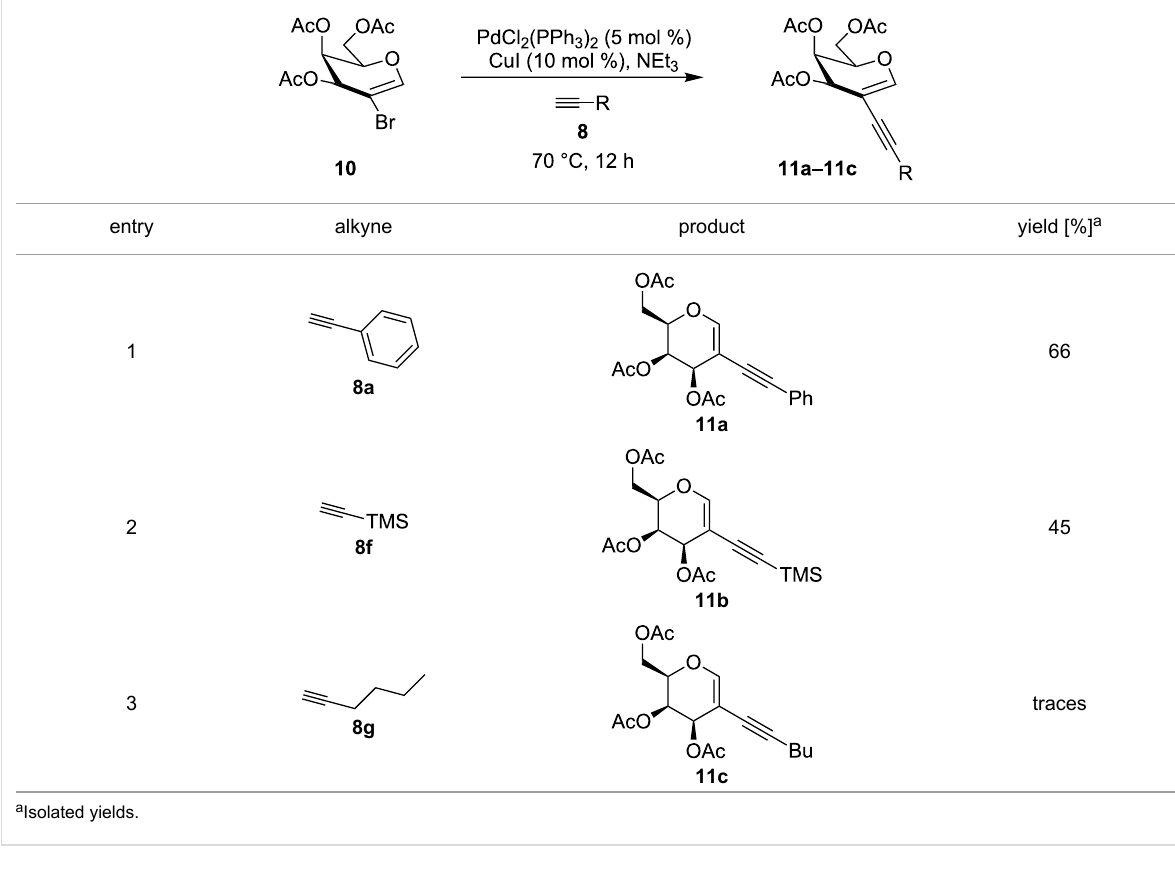
Table 3: Reduction of carbohydrate-derived enynes 9e – 9h and 11a – 11b .